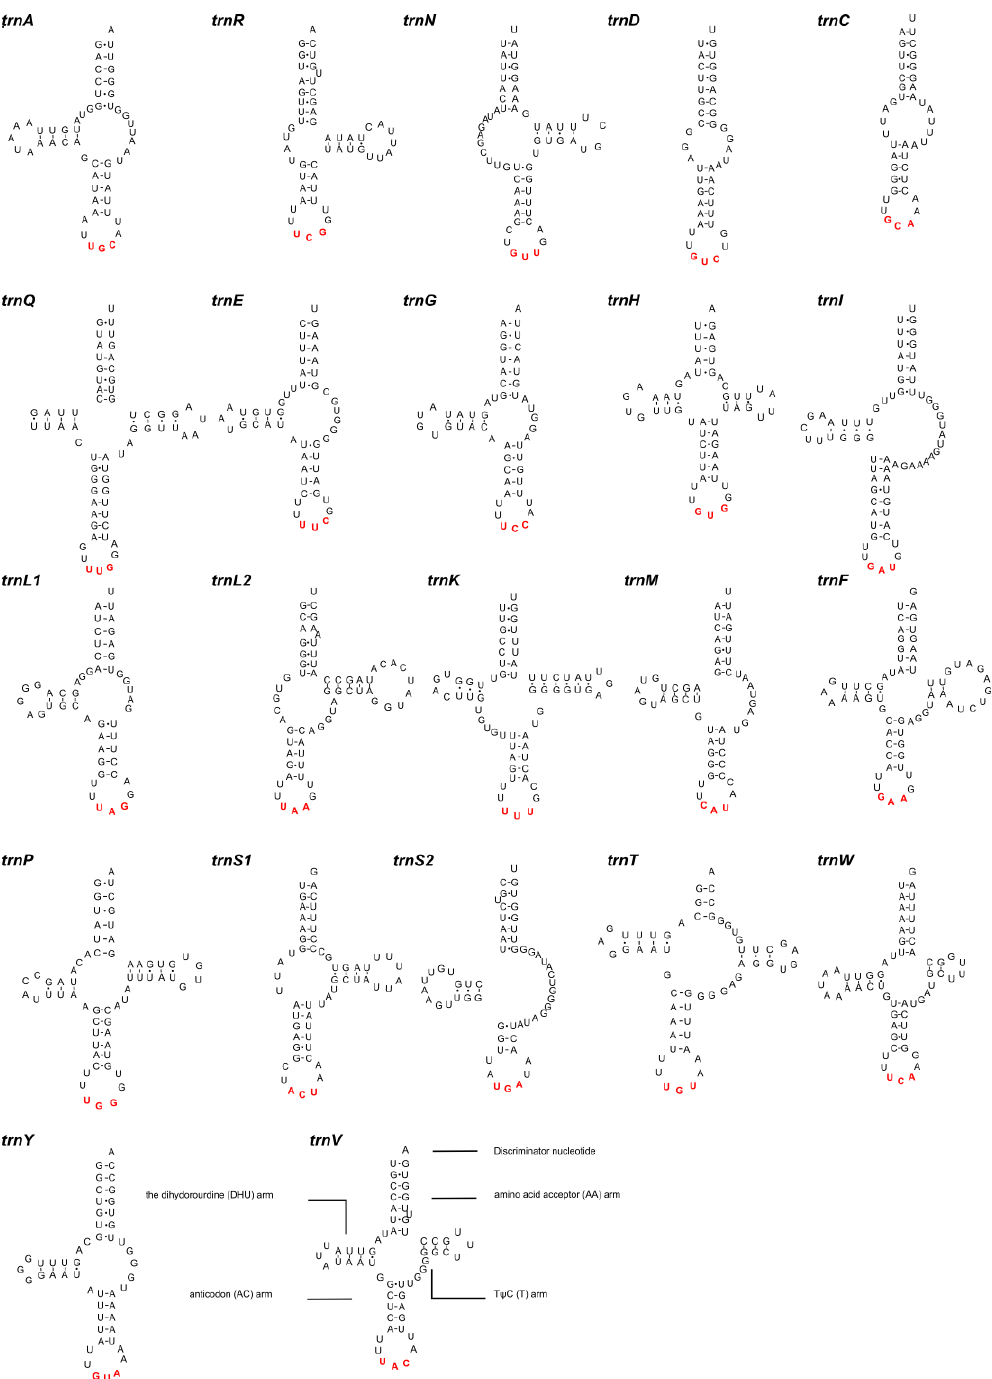
Figure 5. Predicted secondary structures of 22 tRNAs in the mitogenome of Pseudoacanthocephalus bufonis (Watson-Crick bonds indicated by lines, GU bonds indicated by dots, red bases representing anticodons).